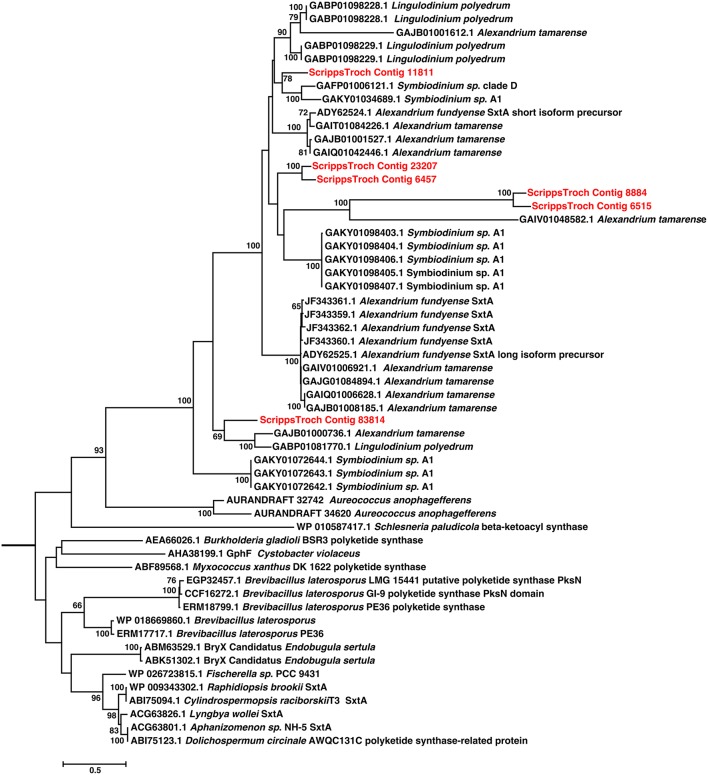
Phylogenetic relationships among Saxitoxin sxtA transcripts from S. trochoidea and close blastp hits to NCBI-NR. Twenty Maximum likelihood searches and 500 Rapid Bootstraps were preformed using RAxML. sxtA hits from S. trochoidea form a clade with others from dinoflagellates. These are related to the sister clade of sxtA from cyanobacteria which are known to produce toxins.